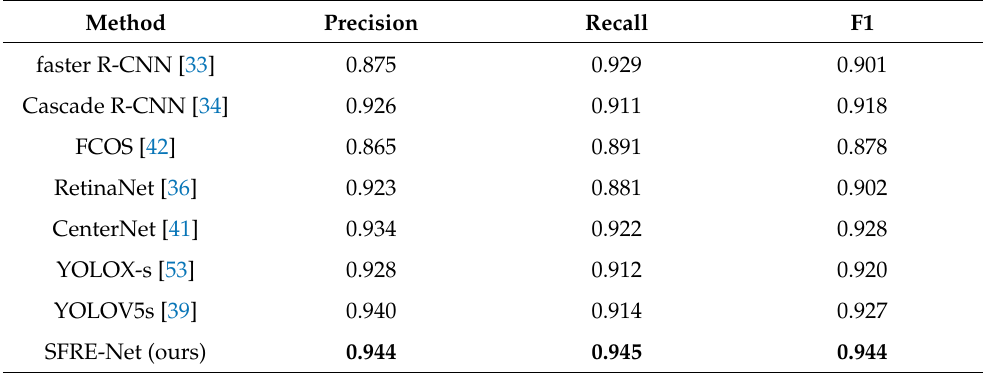
Table 2. Comparison of detection results between different algorithms on